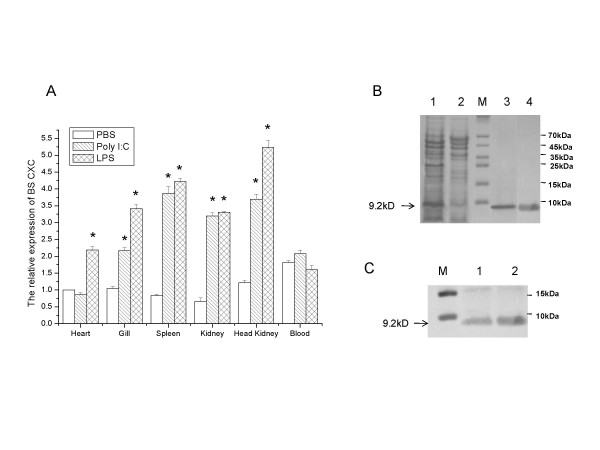
Expression analysis of the BS CXC. (A) The expression of BSCXC mRNA relative to b-actin analyzed by real-time PCR in Black Seabream after PolyI:C and LPS challenge. The values are shown as means ± S.E., n = 3. Significant differences between challenged group and control group are indicated by an asterisk (P < 0.01). (B) The plasmid BS CXC-pQE30 was transformed into E. coli M15 cells and induced by ITPG. Bacterial lysates (lane 1) or purified BS rCXC (lanes 3 and 4) were separated on SDS-PAGE and stained by Coomassie brilliant blue R250. Lysate from uninduced cells was used as a control (lane 2). (C) The identity of the BS rCXC was confirmed by Western blotting using the antibody of 6His. Lanes 1 and 2 showed BS rCXC.